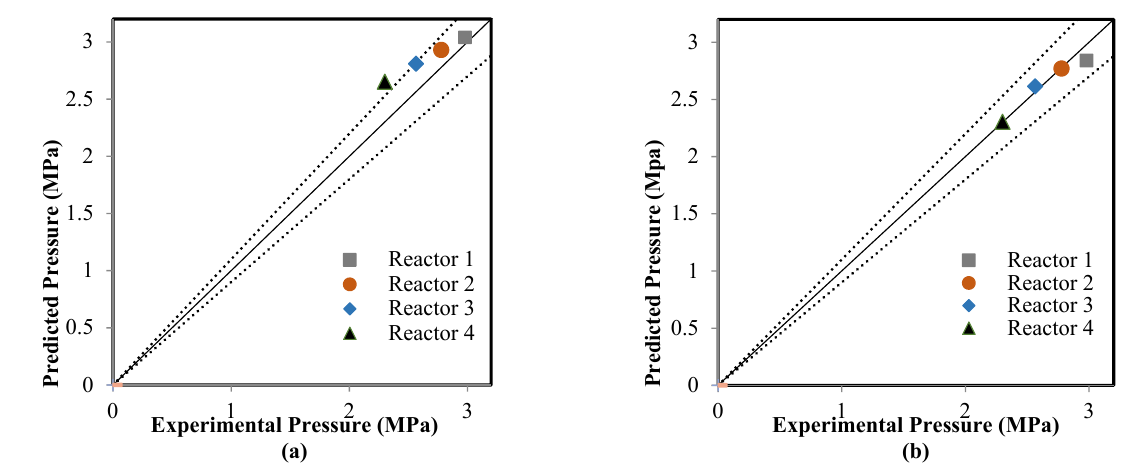
Figure 7. Comparison between the real and predicted temperatures: ( a ) mathematical model, and ( b ) artificial neural net- work.